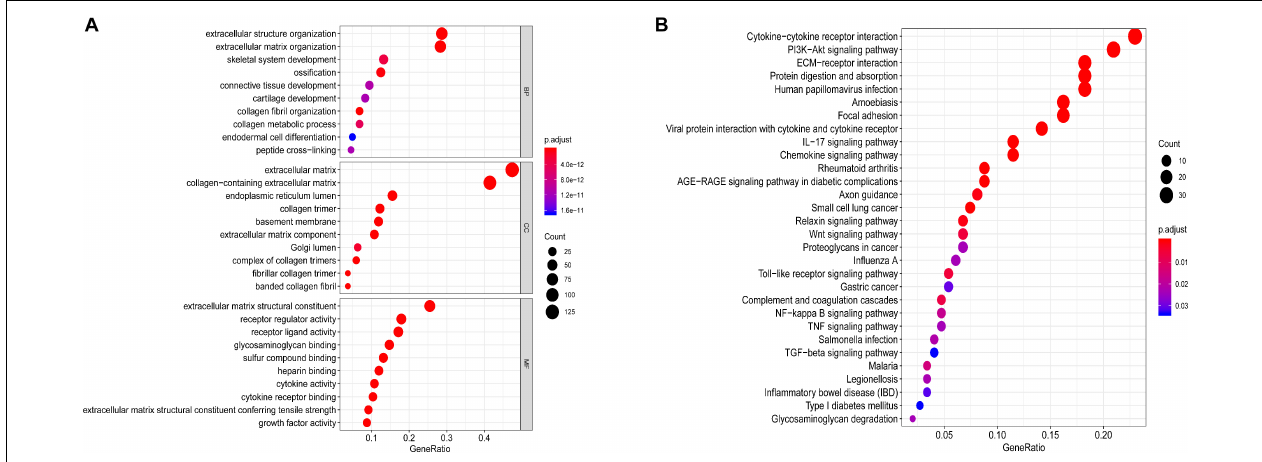
FIGURE 2 | Functional annotations and analysis. (A) GO analysis and (B) KEGG analysis of differentially expressed ECM-related